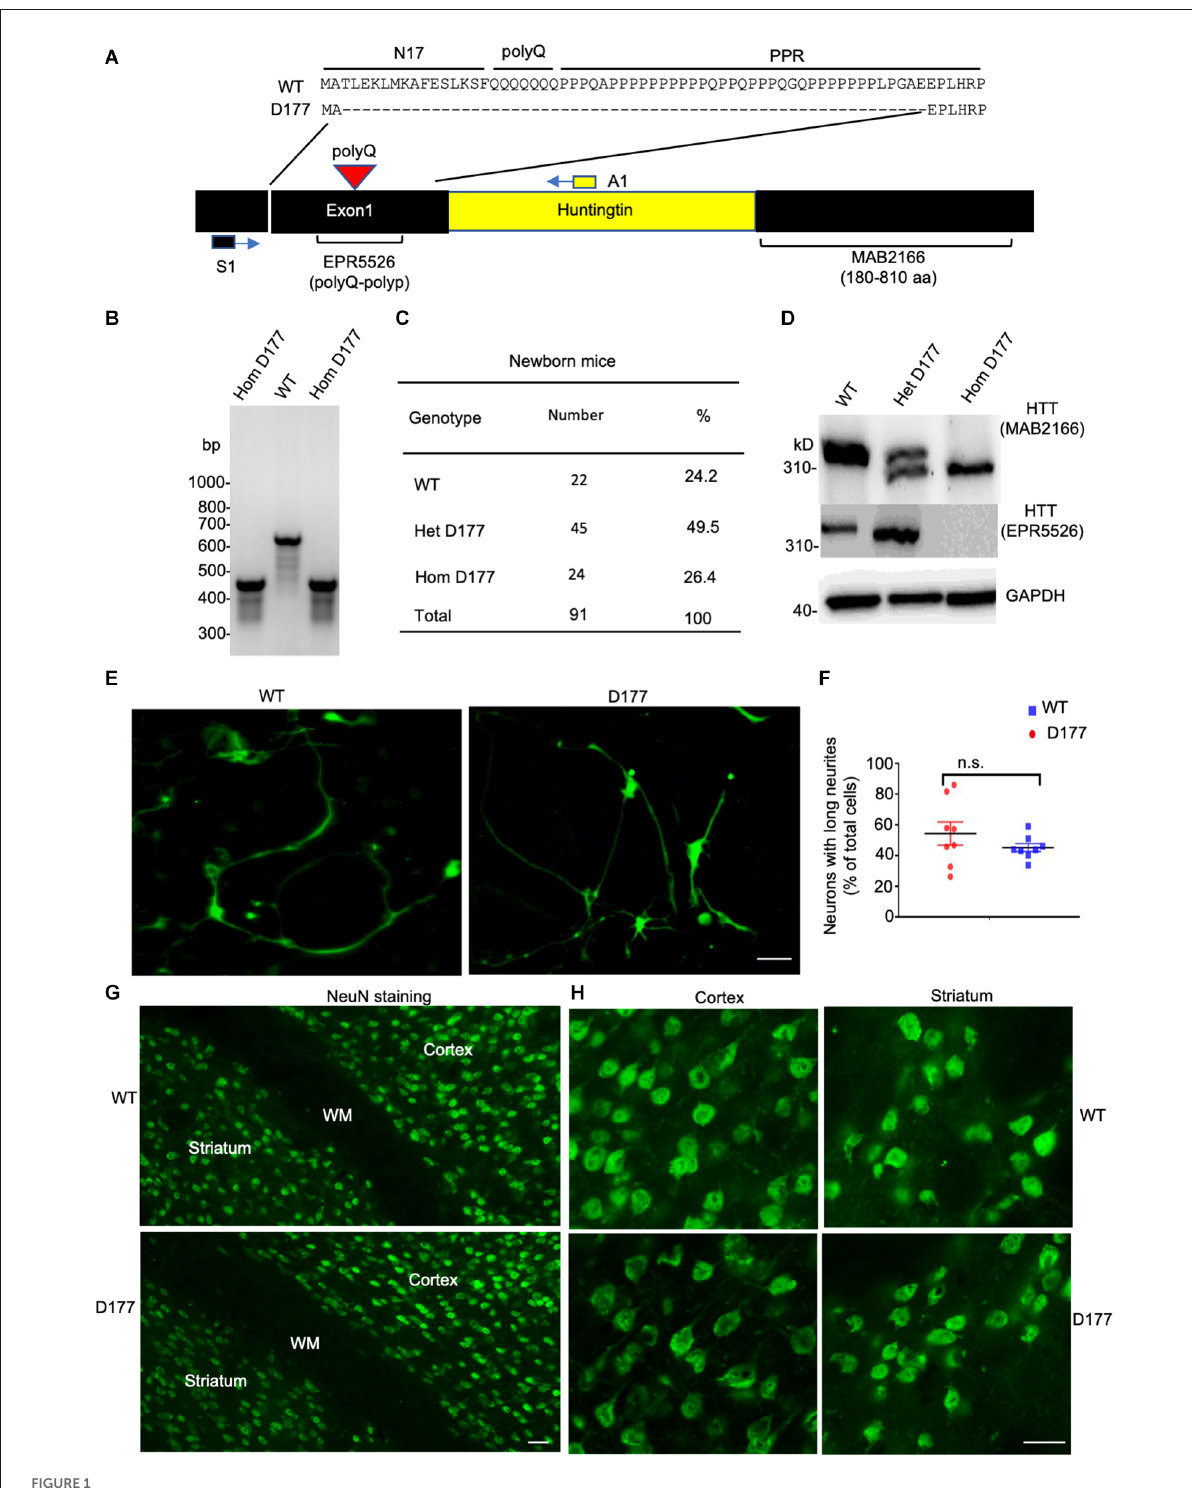
FIGURE1 Deletion of Huntingtin (Htt) exon 1 in D177 mouse. (A) The amino acid sequence of Htt exon 1 in D177 and wild-type mice. Note that exon 1 contains a polyQ repeat. Primers [S1 in exon (black) and A1 in intron (yellow)] for PCR and epitopes of antibodies used for Western blotting are indicated. (B) The genotyping result of D177 homozygous and wild-type mice using PCR primers indicated in (A) . (C) The survival rate of newborn mice of WT, heterozygous or homozygous D177 genotype. (D) Western blotting showing that the brain cortex of heterozygous D177 mouse expressed the wild-type Htt and a mutated Htt lacking exon 1 whereas homozygous D177 mouse